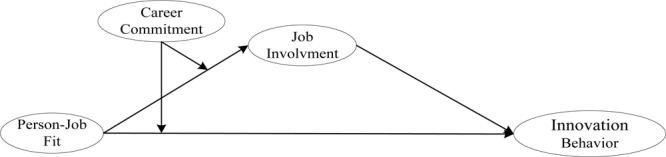
Theoretical model.